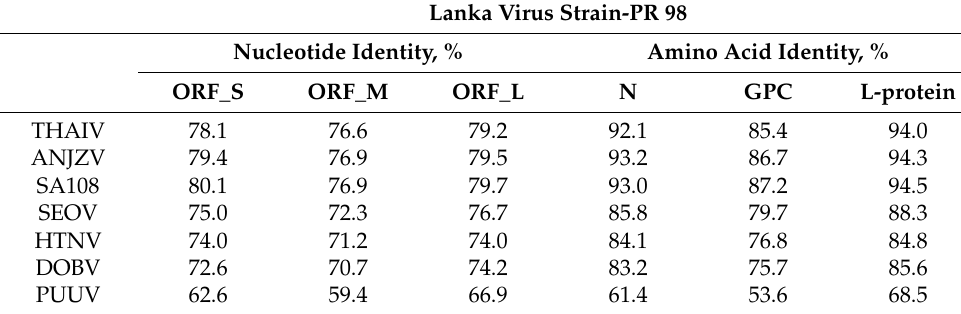
Table 2. Nucleotide and amino acid sequence identities of S, M, and L segment ORFs and their corresponding encoded proteins of the Lanka virus strains PR98 with SA108 and other representative Muridae-born